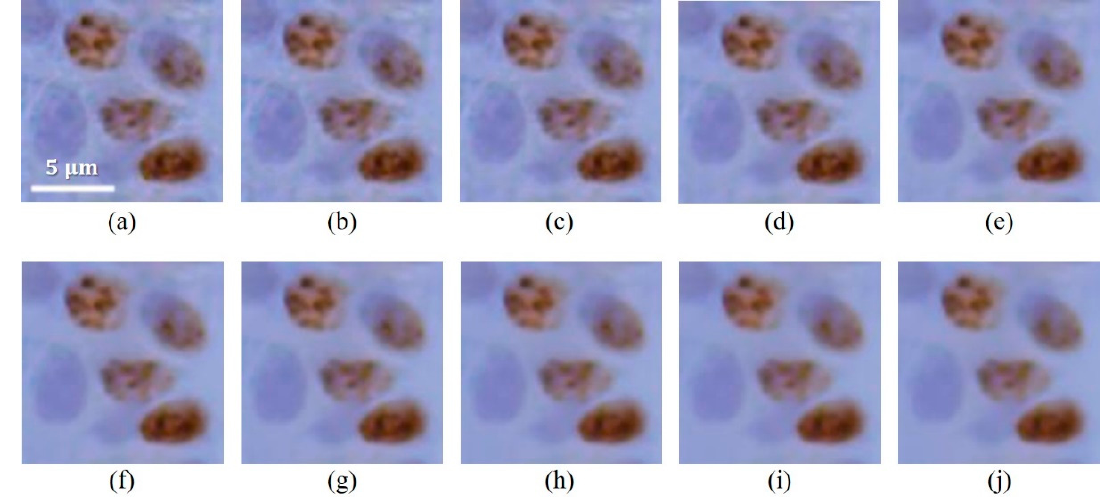
Figure 2. Color LM images filtered using FNLM algorithm (scale bar = 5 µ m) with various smoothing factors: ( a ) 0.01, ( b ) 0.0125, ( c ) 0.015, ( d ) 0.02, ( e ) 0.025, ( f ) 0.03, ( g ) 0.035, ( h ) 0.04, ( i ) 0.045, and ( j ) 0.05.